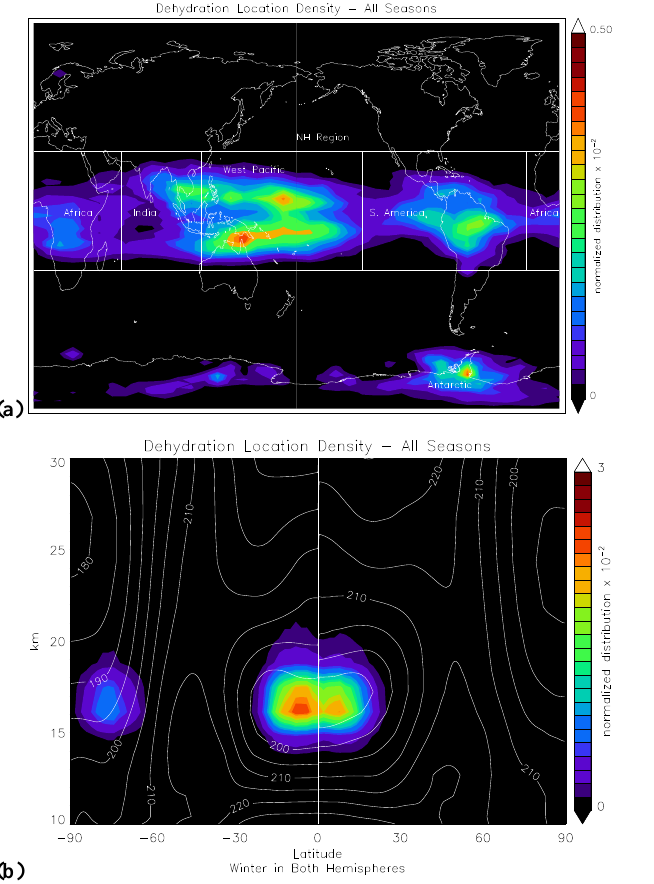
Fig. 8. Upper plot (a) shows horizontal distribution of final dehy- dration location density for all parcels more than 1yr old, regardless of when they were dehydrated (from the D100 run). The lower plot (b) shows the annual vertical distribution of dehydration locations along with the winter zonal mean temperature contours superim- posed (winter in the SH and winter in the NH).